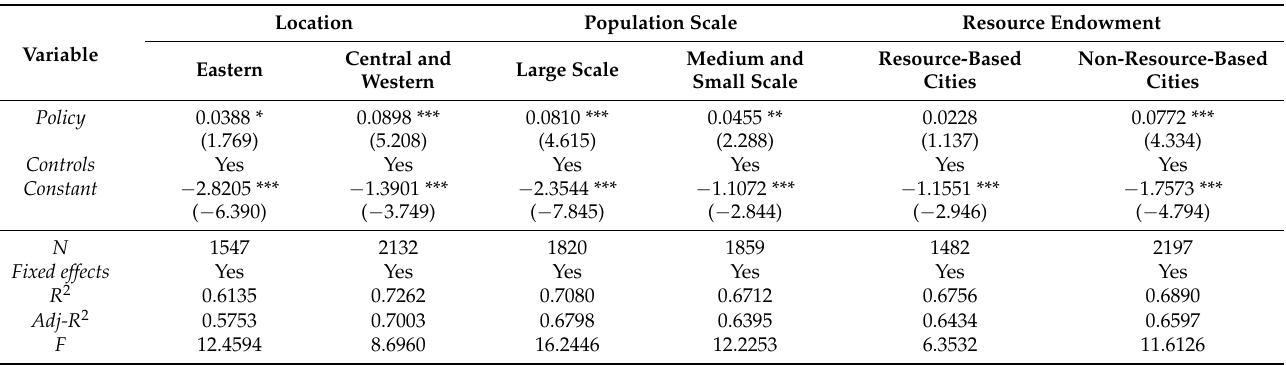
Table 6. Impact heterogeneity discussion.